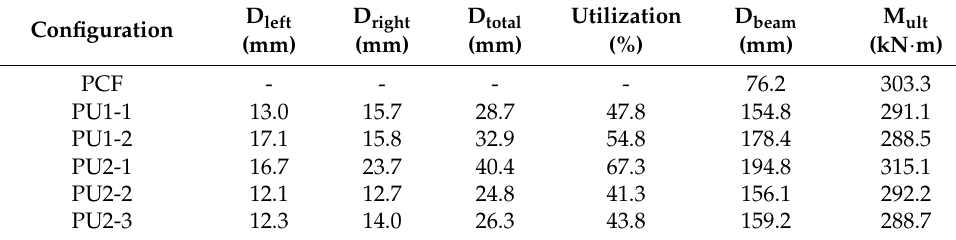
Table 6. Ductile mechanism deformation compared to ultimate moment and